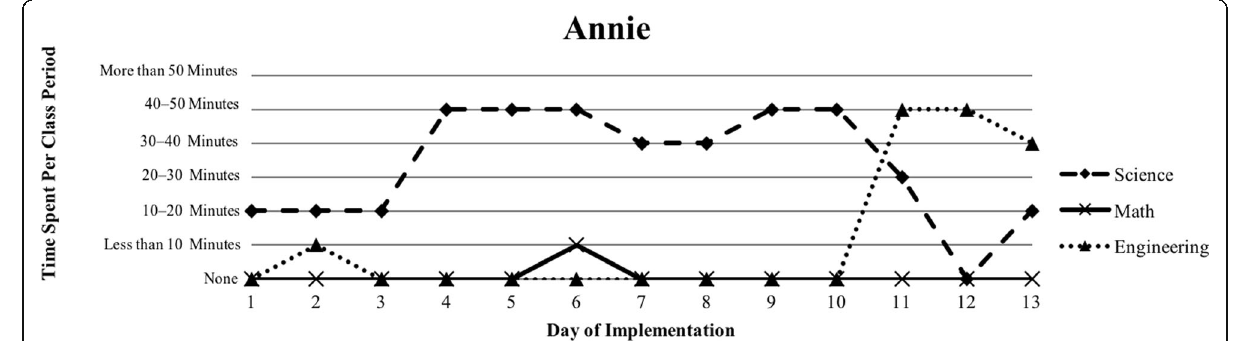
Fig. 2 Annie ’ s implementation of the Particle Nature of Matter in her 6th grade science